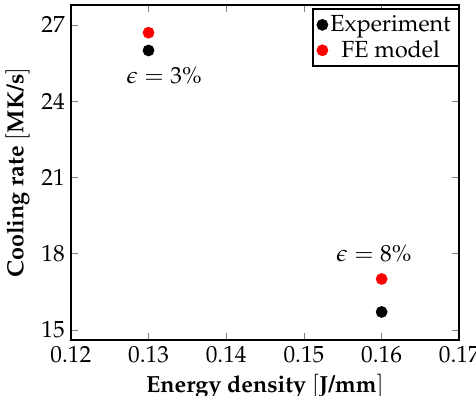
Figure 3. Dependence of cooling rates obtained from experiments and the FE model on the en- ergy density, P . The average cooling rate from the FE model was estimated using the relation: ν p ˙ T = G ν p = | ∇ T | ν p . Laser power (W) and scan speed (mm/s) combinations used for this study were ( P , ν p ) = ( 90,575 ) , ( 90,675 )